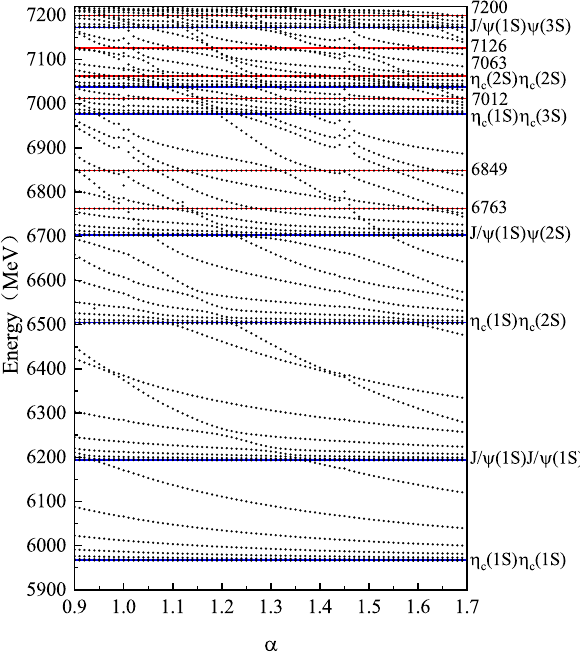
Figure 6. The stabilization plots for the energies of the states for J PC = 0 ++ obtained by considering the coupling between two diquark–antidiquark structures ( DA ) 0 states ( η c η c ) 0 + ( J / ψ J / ψ ) 0 with respect to the scaling factor α .